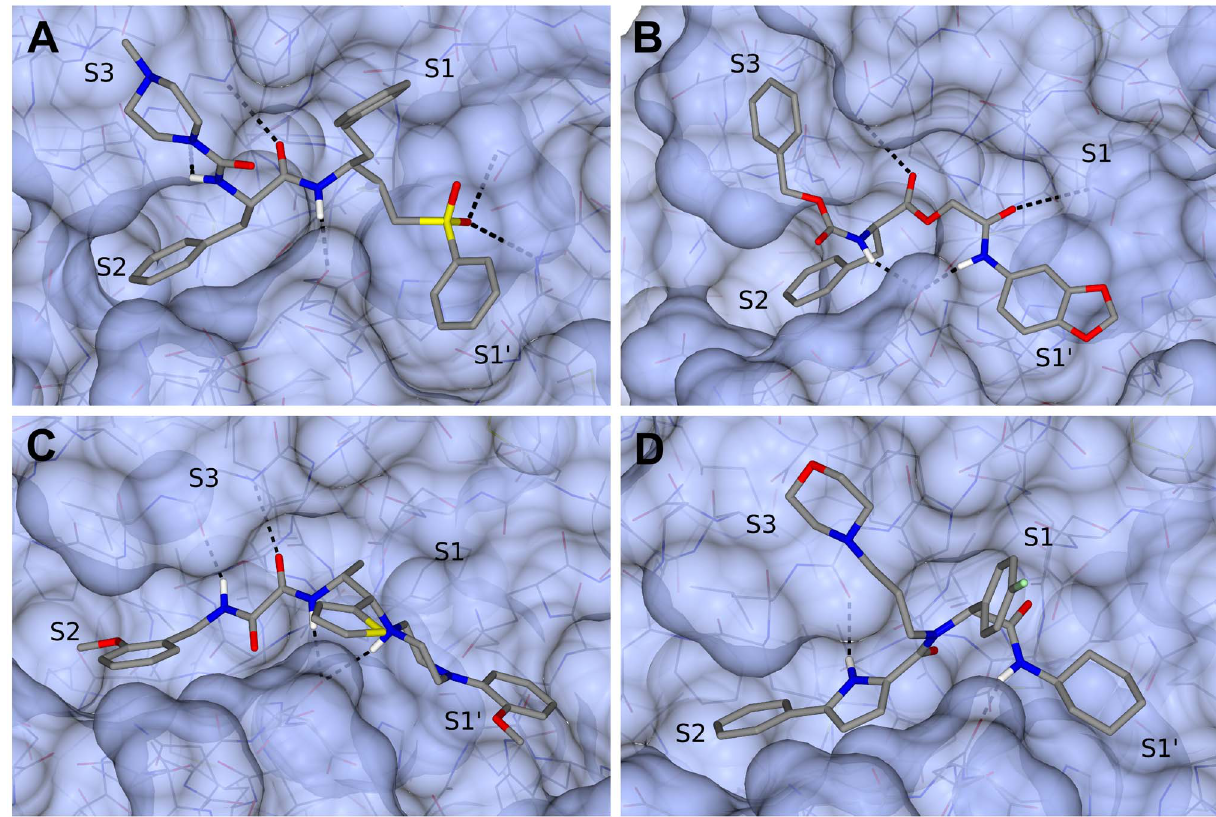
Figure 3. (A) Structure of the co-crystallized cruzain inhibitor K11777 and (B–D) examples of complex structures predicted by our molecular docking (Glide XP). Figure prepared using CCP4mg software [43].